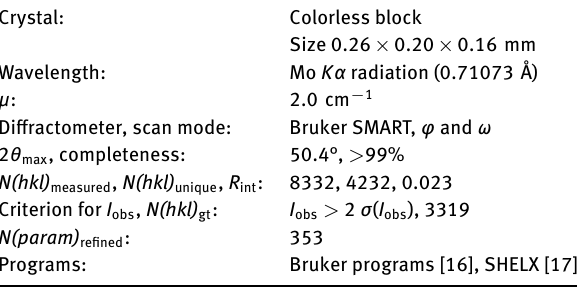
Table 1: Data collection and handling. Crystal: